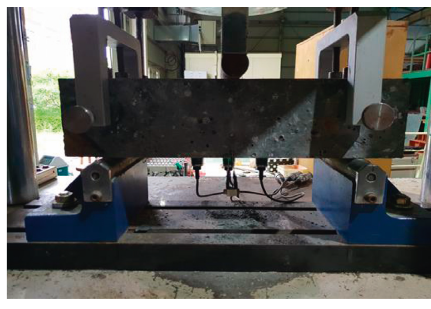
Figure 1: CMOD test